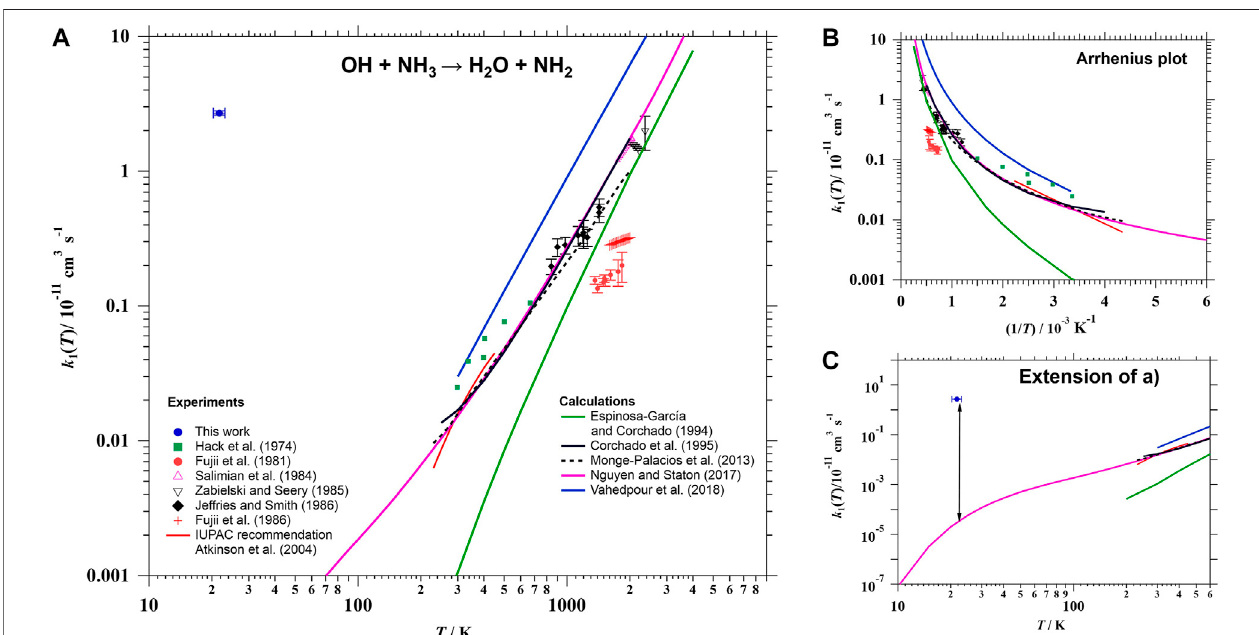
FIGURE 4 | (A) Temperature dependence of k 1 (log-log plot) in the 22 – 4,000 K range. Individual rate coef fi cients at room temperature K (Zellner and Smith, 1974; Perry et al., 1976; Silver and Kolb, 1980; Stephens, 1984; Diau et al., 1990) are not included in the fi gure, but they are considered in the IUPAC recommendation (red curve). (B) Arrheniusplotfor k 1 between170and4,000 Ktobetterseethecurvature(non-Arrheniusbehavior). (C) Extensionofthelog-logplotshownin (A) toshowthe great enhancement of k 1 with respect to theoretical predictions at 20